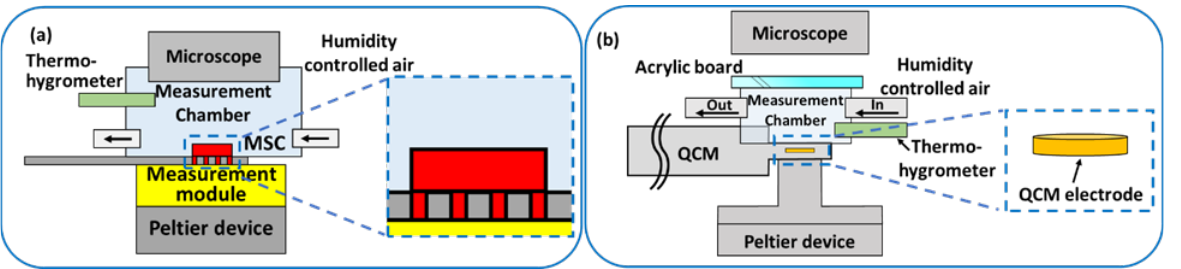
Figure 2. A schematic illustration for the experimental setup used for water adsorption/condensation detection using MSC ( a ) and QCM surfaces ( b ), respectively.